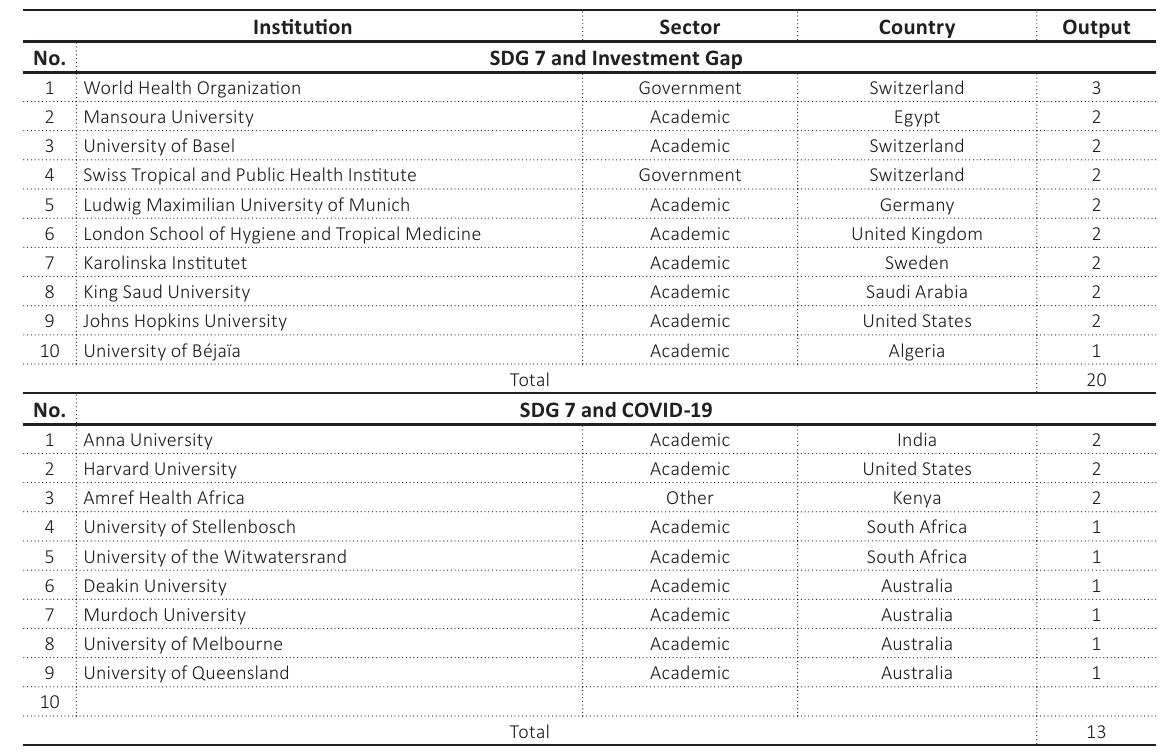
Table B1 (cont.). Top 10 institutions, sectors and countries in each research area by scholarly